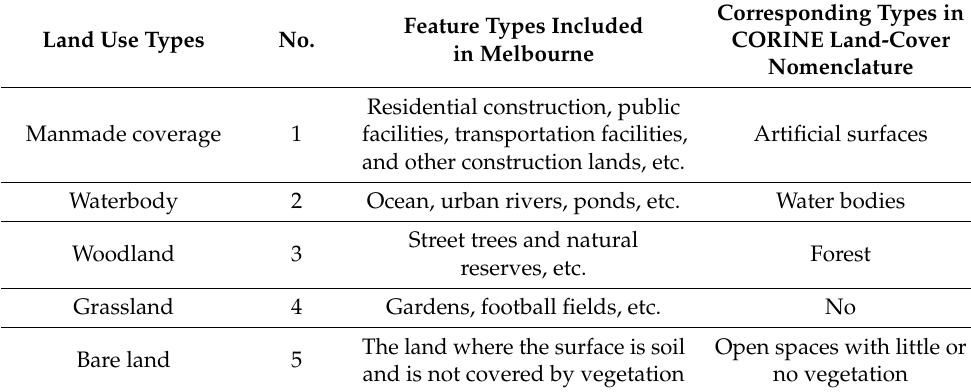
Table 1. Interpretation of land types and landscape category